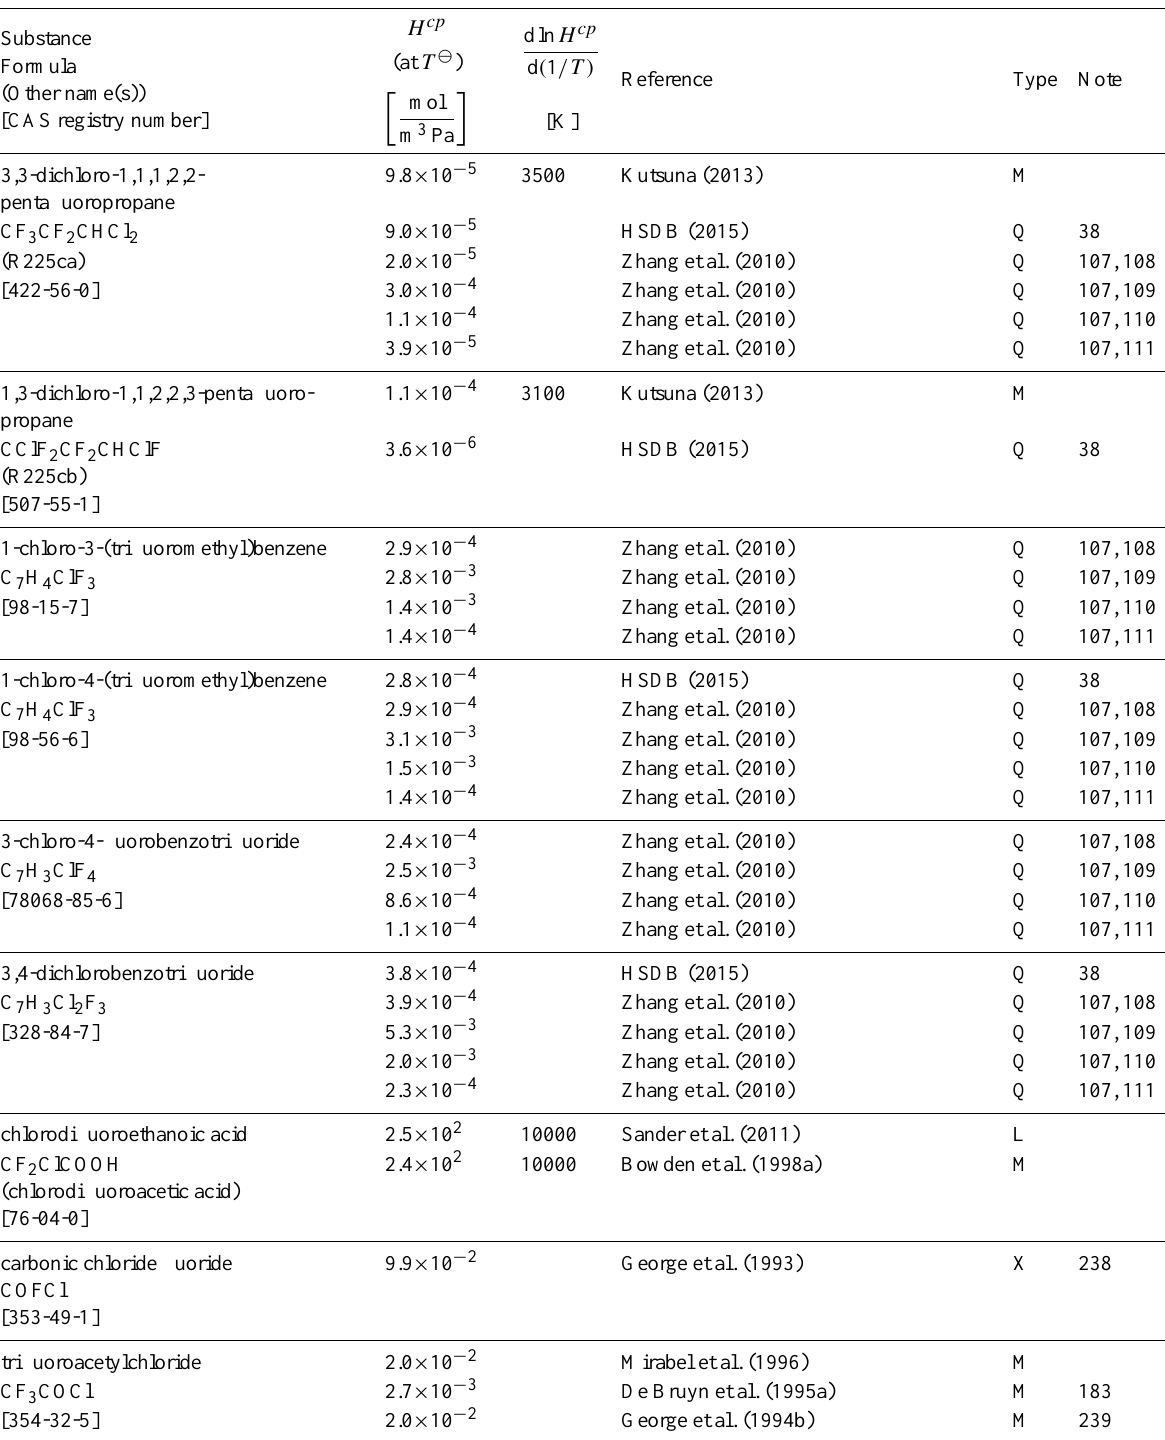
Table 6: Henry’s law constants for water as solvent